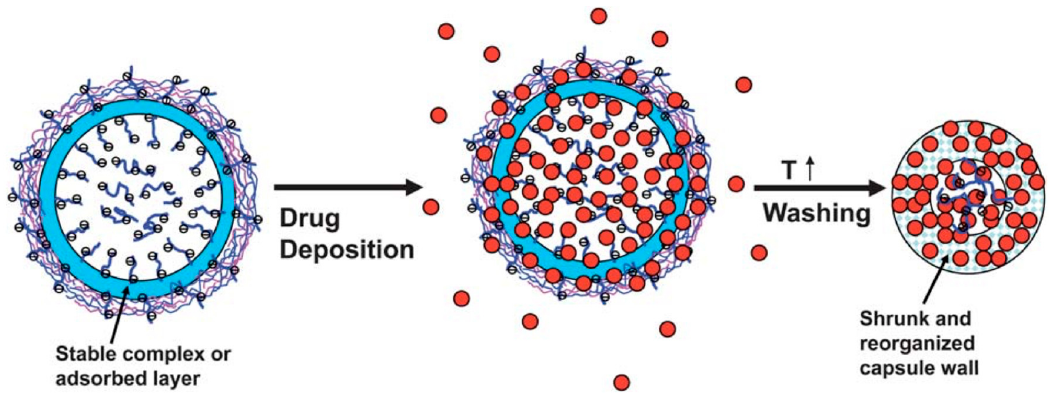
Figure 3. Schematic illustration of the loading of low-molecular-weight (LMW) drugs into PSS-loaded (PDADMAC)/PSS) 5 -PSS multilayer capsules through a combination of the spontaneous deposition process and heat-driven shrinkage of capsules. The blue layer refers to the adsorbed layer, which is formed from the first PDADMAC layer and free PSS polyelectrolyte during the crystal dissolution process. The pale blue rhombus refers to the shrunk and re-organized capsule shell. This schematic is taken with permission from Reference [76], copyright© 2011, Royal Society of Chemistry.